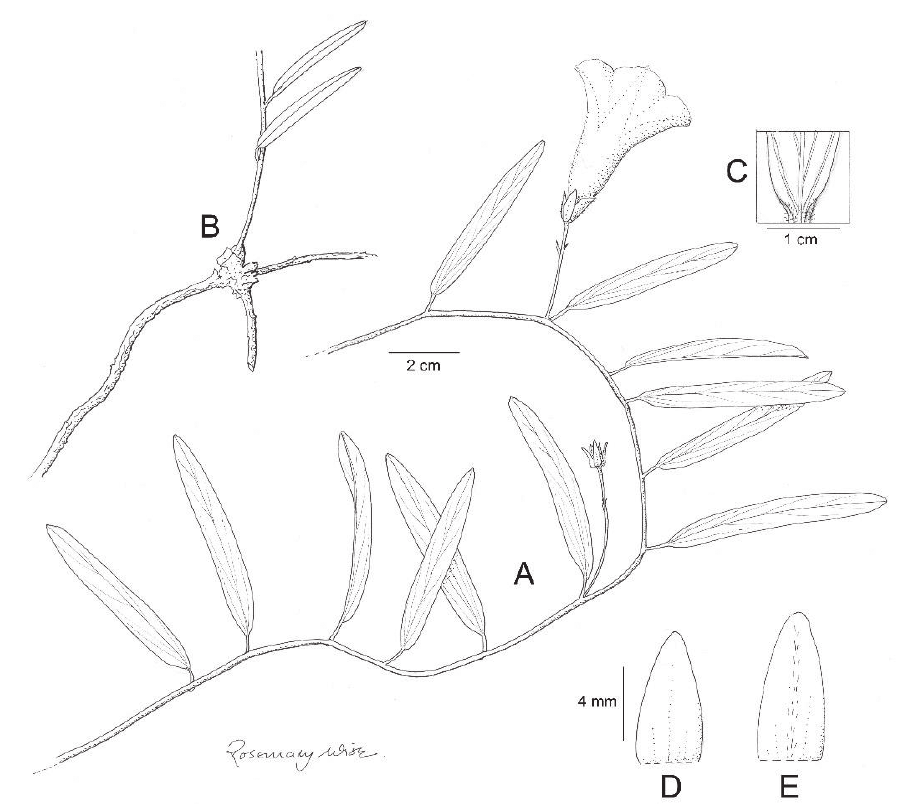
Figure 8. Ipomoea ensiformis. A habit B rootstock C base of young leaves showing indumentum D Outer sepal e inner sepal. Drawn by Rosemary Wise from Gates & Estabrook